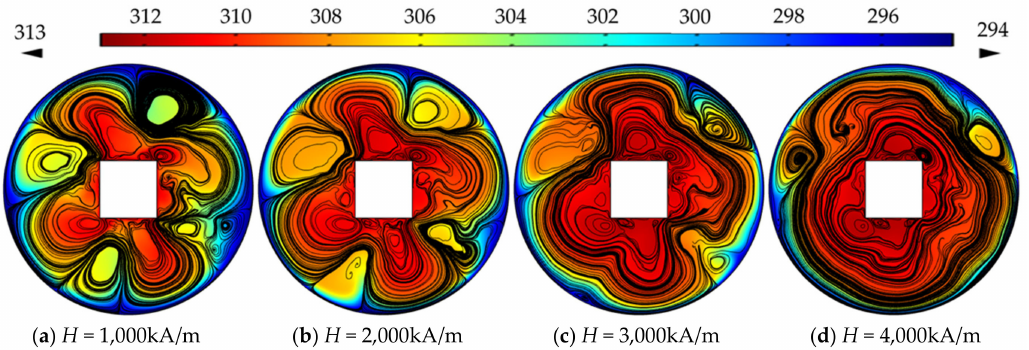
Figure 6. Streamlines and temperature distribution in a circle channel with the di ff erent magnetic field strength.